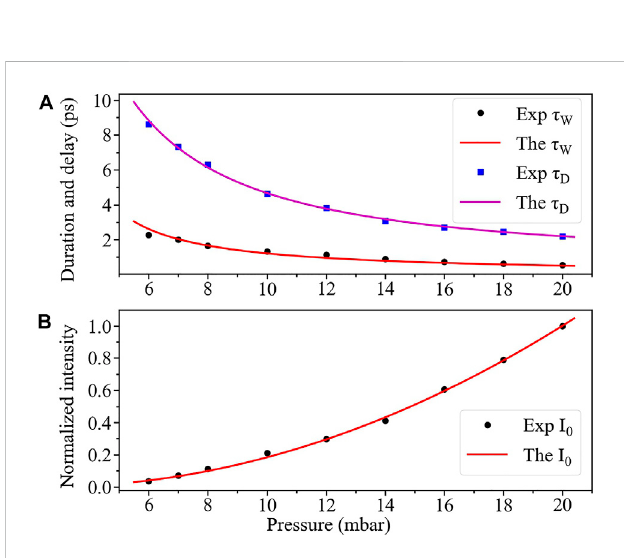
FIGURE 4 Comparisons between (A) the experimental characteristic duration τ τ W and time delay D , and the calculated experimental results of peak intensity I 0 and the theoretical calculations of I 0 as a function of gas